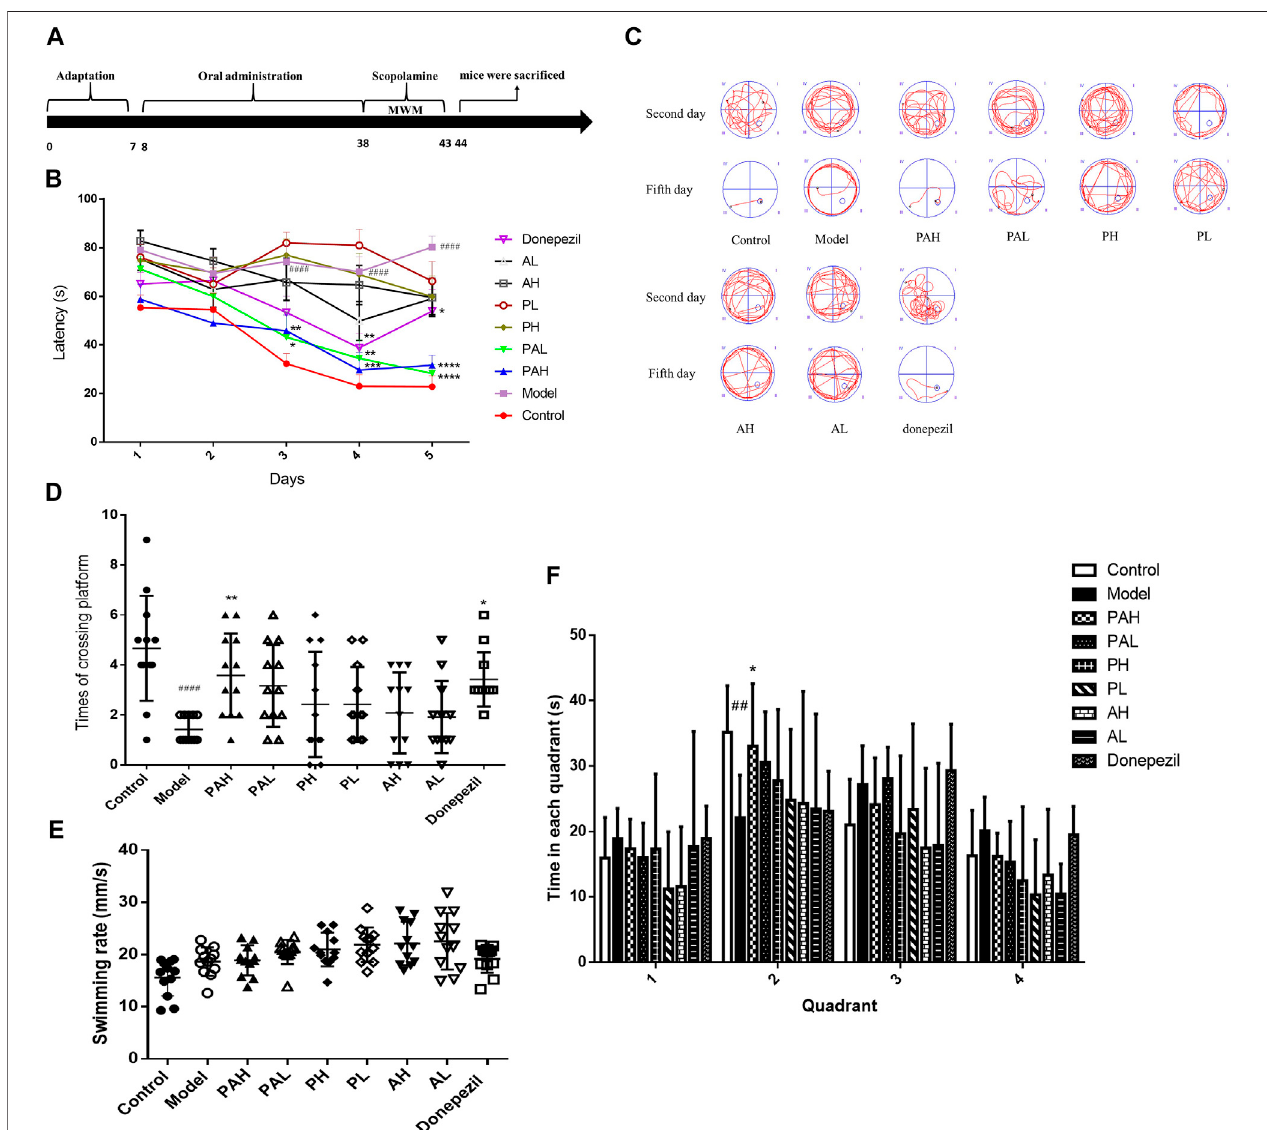
FIGURE 4 | Spatial learning and memory ability of mice as evaluated with the Morris water maze test. ( A ) Experimental schedule of PA administration in scopolamine-treated mice.( B ) Latency to fi nd a hidden platform in the water maze over fi ve consecutive days of training.( C ) Representative search strategy of mice on days 2 and 5. Traces show the swimming paths of each group of mice.( D ) Number of platform crossing in 90 s. E. Swimming rate of each group of mice. F. Time to the different quadrant in the probe test. Data represent mean ± S.D. ( n (cid:1) 12). ## p < 0.01, #### p < 0.0001 vs control mice; * p < 0.05, ** p < 0.01, *** p < 0.001, and **** p < 0.001 vs scopolamine-treated